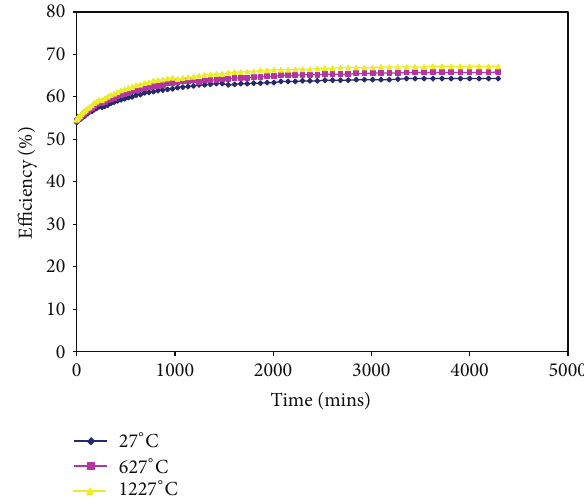
Figure 5: Impact of temperature of input air on conversion efficien-